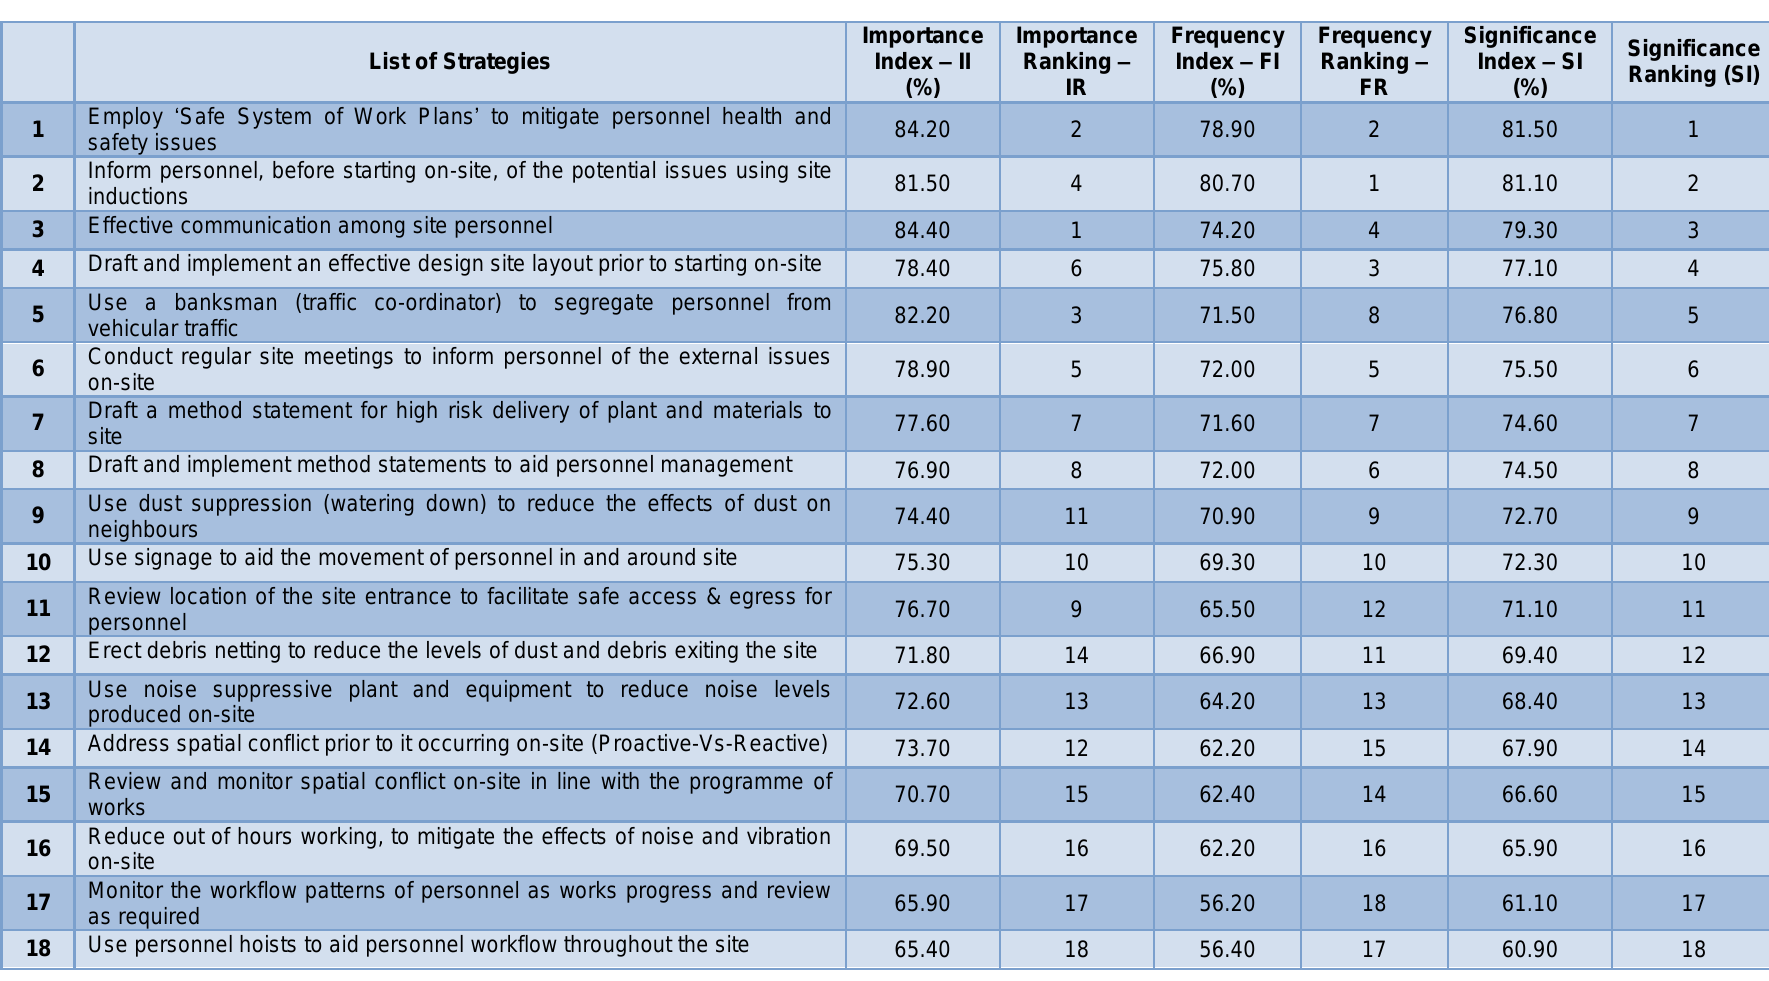
Table 1 Strategies for Effective Health and Safety Management in Confined Site Construction and their